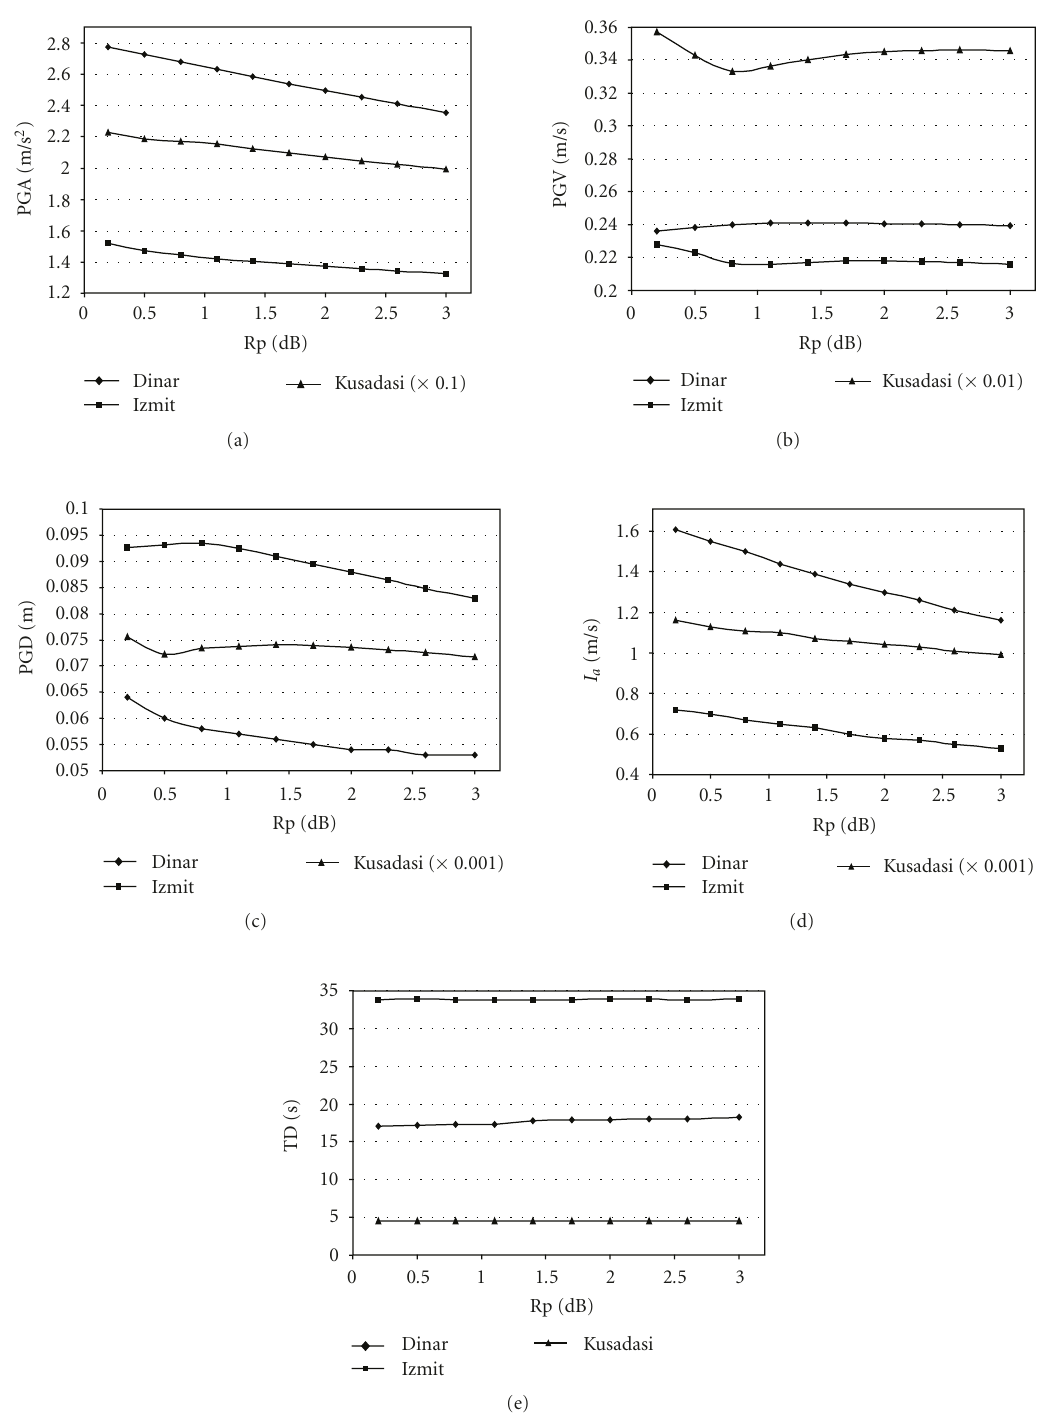
Figure 2: Strong-motion parameters as a function of the passband ripple Rp [dB] (NS component). Note: di ff erent scales for Kusadasi